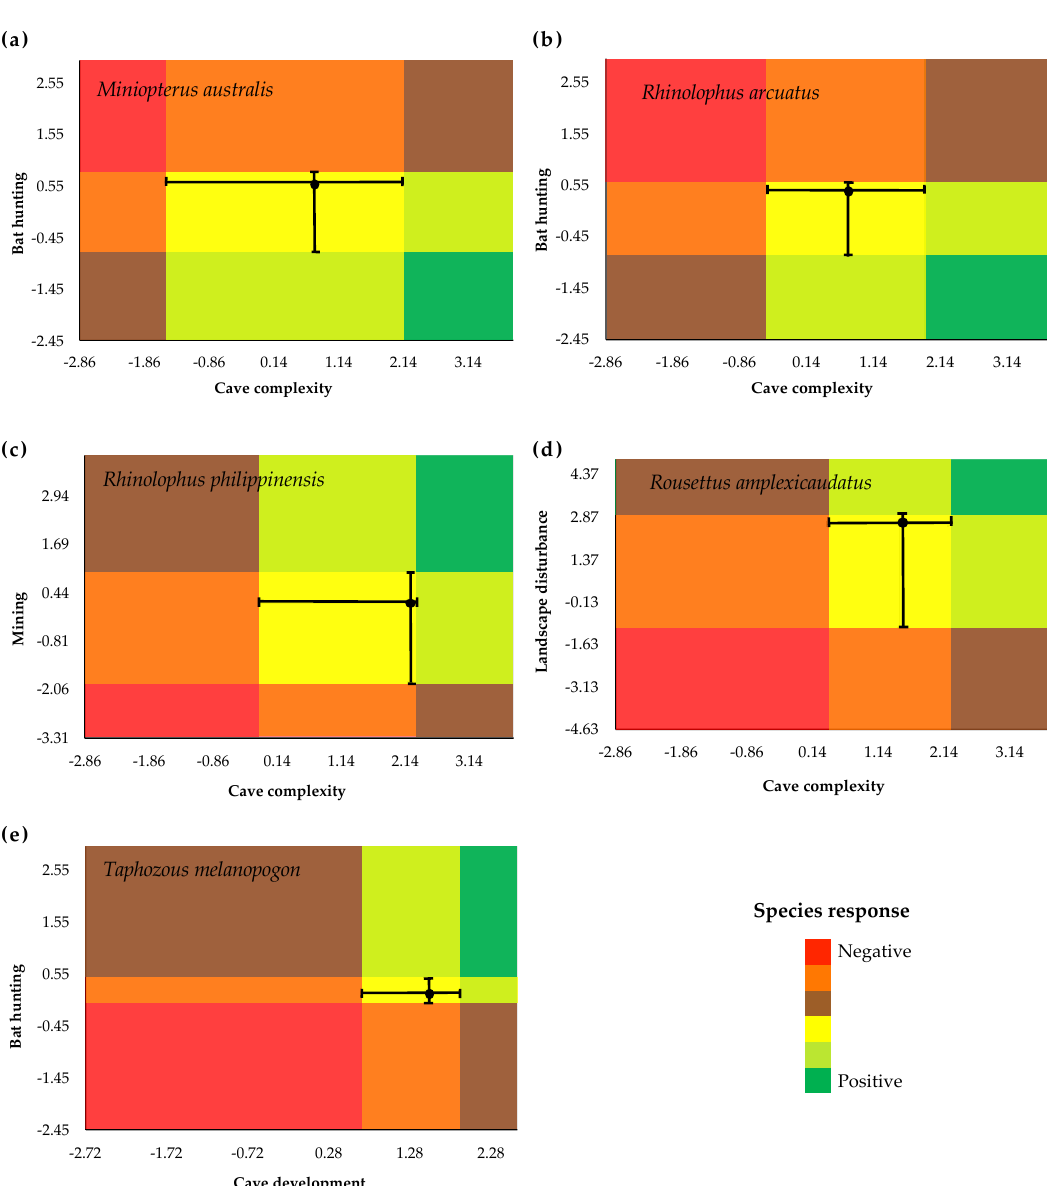
Figure 4. Threshold responses of indicator species to environmental and human disturbance gradients. Two-dimensional response plots depict ecological thresholds of indicator species along environmental and human disturbance gradients and predict distribution of conditions influencing species occurrence and abundance in caves. Specific thresholds ( ± 95 confidence intervals) along each gradient are identified by cross-hair symbol, with color-coded zones representing above (green), within (yellow), and below (red) the 95% CI for both gradients. Congruence in response direction in these zones are identified by these color-codes, while incongruent responses are represented by overlapping shades of these color-codes. Miniopterus australis ( a ) and Rhinolophus arcuatus ( b ) exhibit a negative response to bat hunting but positive response to cave complexity. Rhinolophus philippinensis ( c ) and Rousettus amplexicaudatus ( d ) prefer complex caves with mining and landscape disturbance, respectively. Taphozous melanopogon ( e ) responded positively to bat hunting and cave